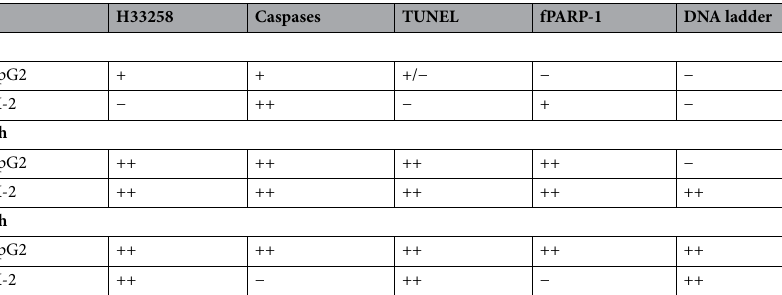
Table 2. Comparison of assays detecting pro-apoptotic changes. HepG2 and HK-2 cells were treated with 100 µM CisPt for 6, 24 and 48 h. After treatment, the nuclear changes were detected using five methods, i.e. developed spectrofluorometric assay using Hoechst 33258 (= H33258), caspase 3/7 activity, TUNEL assay, protein expression of PARP-1 fragment (fPARP-1) and DNA ladder. (−, negative; +/−, moderately positive; +, positive; ++, strongly